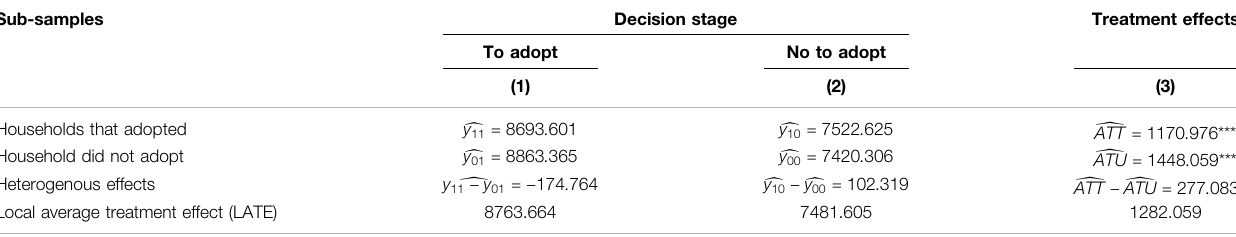
TABLE 3 | Treatment effects of improved organic manure practice on crop